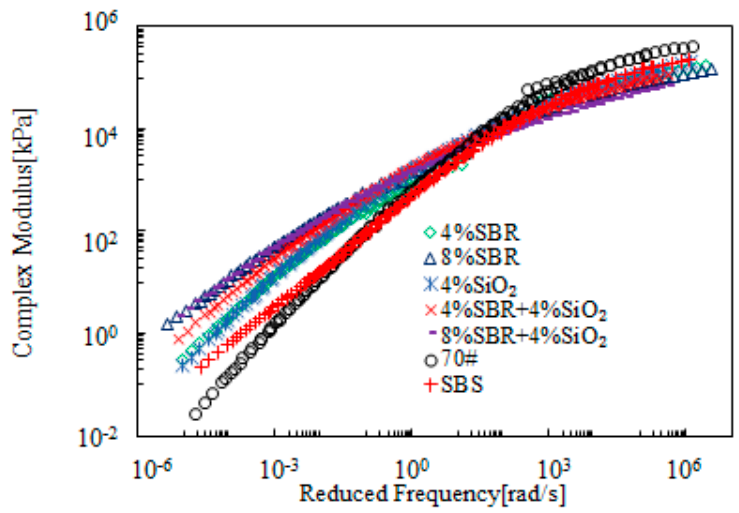
Materials 2019 , 12 , x FOR PEER REVIEW Figure 15. Master curves of complex modulus of SBR + SiO 2 -modified bitumen emulsion. Figure 15. Master curves of complex modulus of SBR